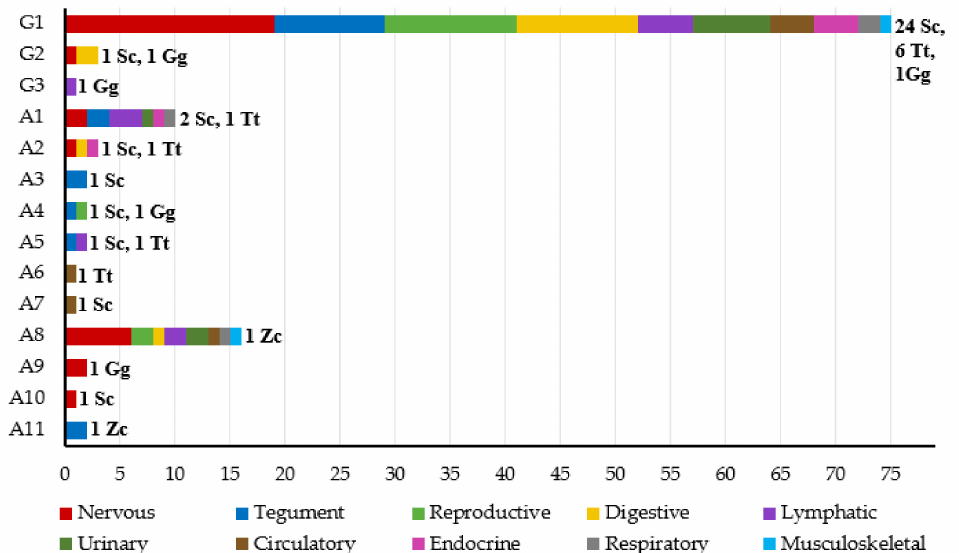
Figure 7. Frequency of detection of each unique HV sequence in tissues of each organ system. Sequences amplified in this study were assigned identifiers from A1 to A11 ( Alphaherpesvirinae ) and G1 to G3 ( Gammaherpesvirinae ). The number of individuals of each species in which the se- quence was found is shown. Sc, Stenellacoeruleoalba ; Tt, Tursiops truncatus ; Gg, Grampus griseus ; Zc, Ziphius cavirostris